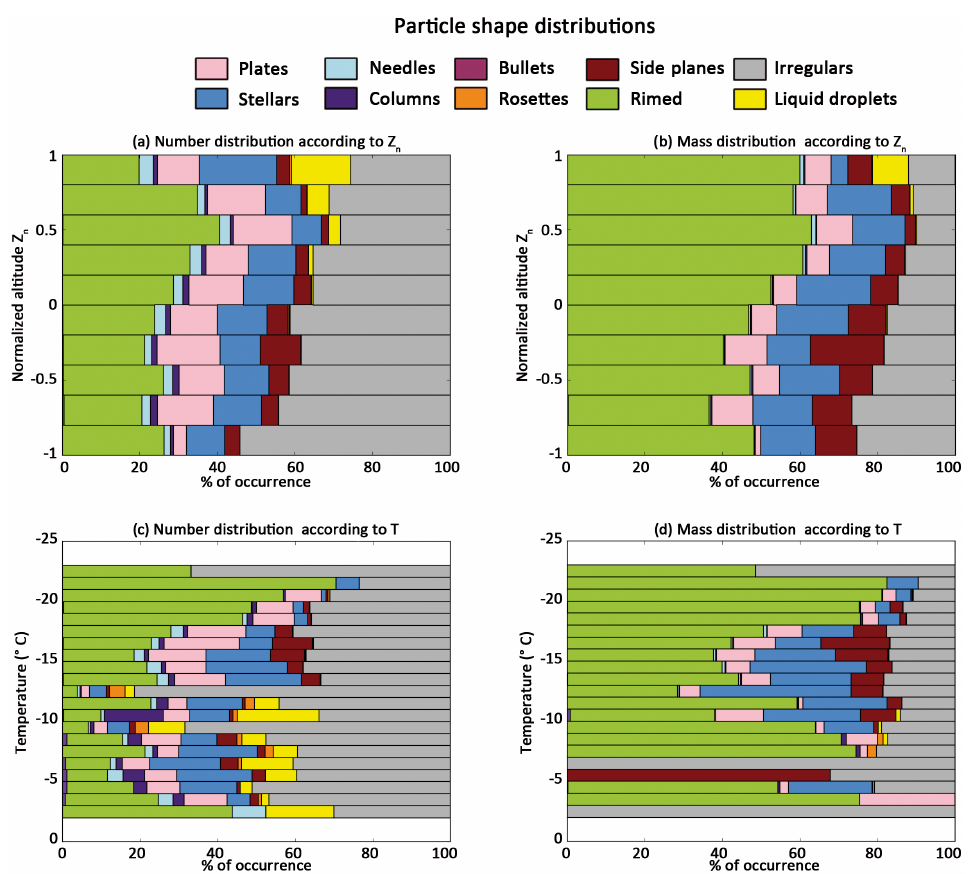
Figure 6. Vertical profiles of particle shapes (from CPI measurements and for particles larger than 100µm) according to normalized altitude (a, b) and temperature (c, d) . Distributions are displayed according to particle number (a, c) and mass (b, d)